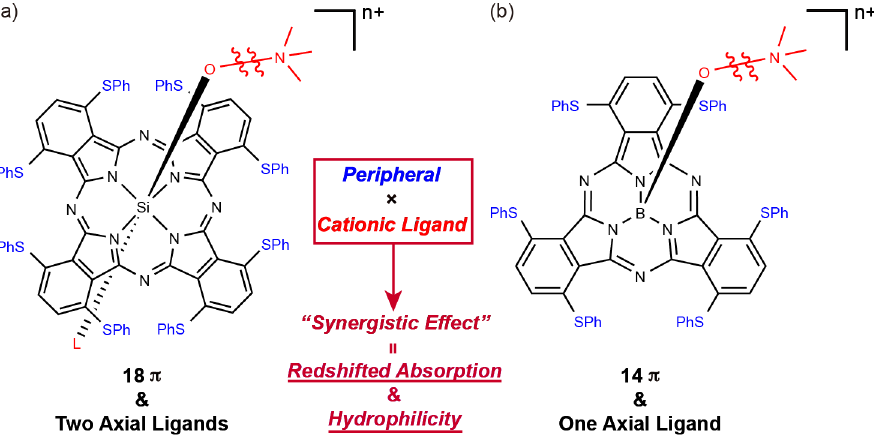
Figure 1. Structures of: ( a ) silicon(IV) phthalocyanine and ( b ) boron(III) subphthalocyanine with cationic axial ligands.